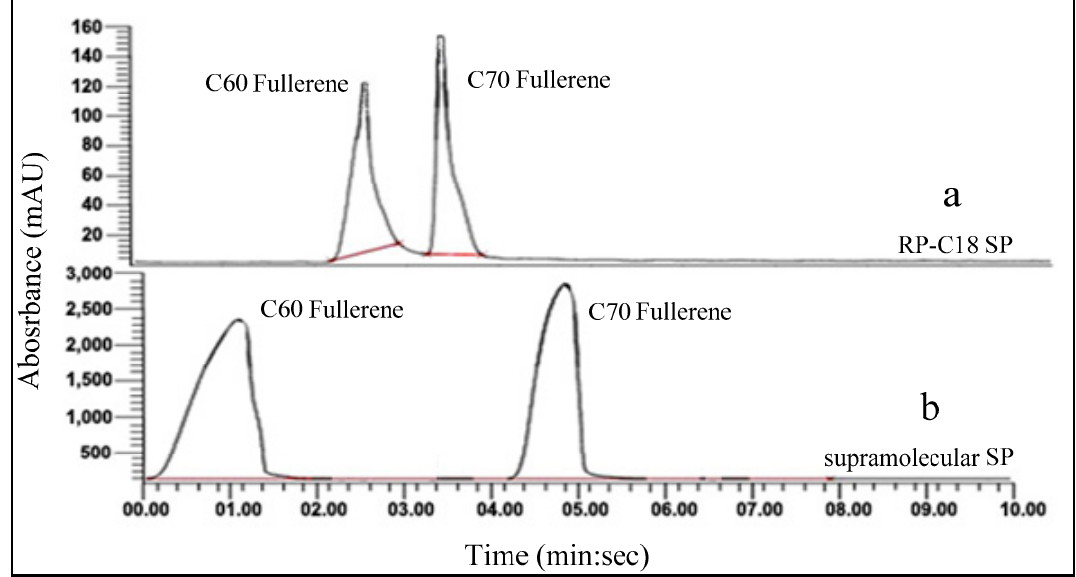
Figure 4. HPLC separation of C 60 and C 70 fullerene standards on ( a ) RP-C 18 and ( b ) C -butylpyrogallol[4]arene bonded-silica column. Analyte concentration: 50 μ g mL − 1 in toluene, detection wavelength: 237 nm, mobile phase: water:methanol (40:60), flow rate: 1.0 mL min − 1 , elution: isocratic, run time: 10 min, column dimensions: 150 × 4.6 mm i.d., column temperature: ambient room temperature.